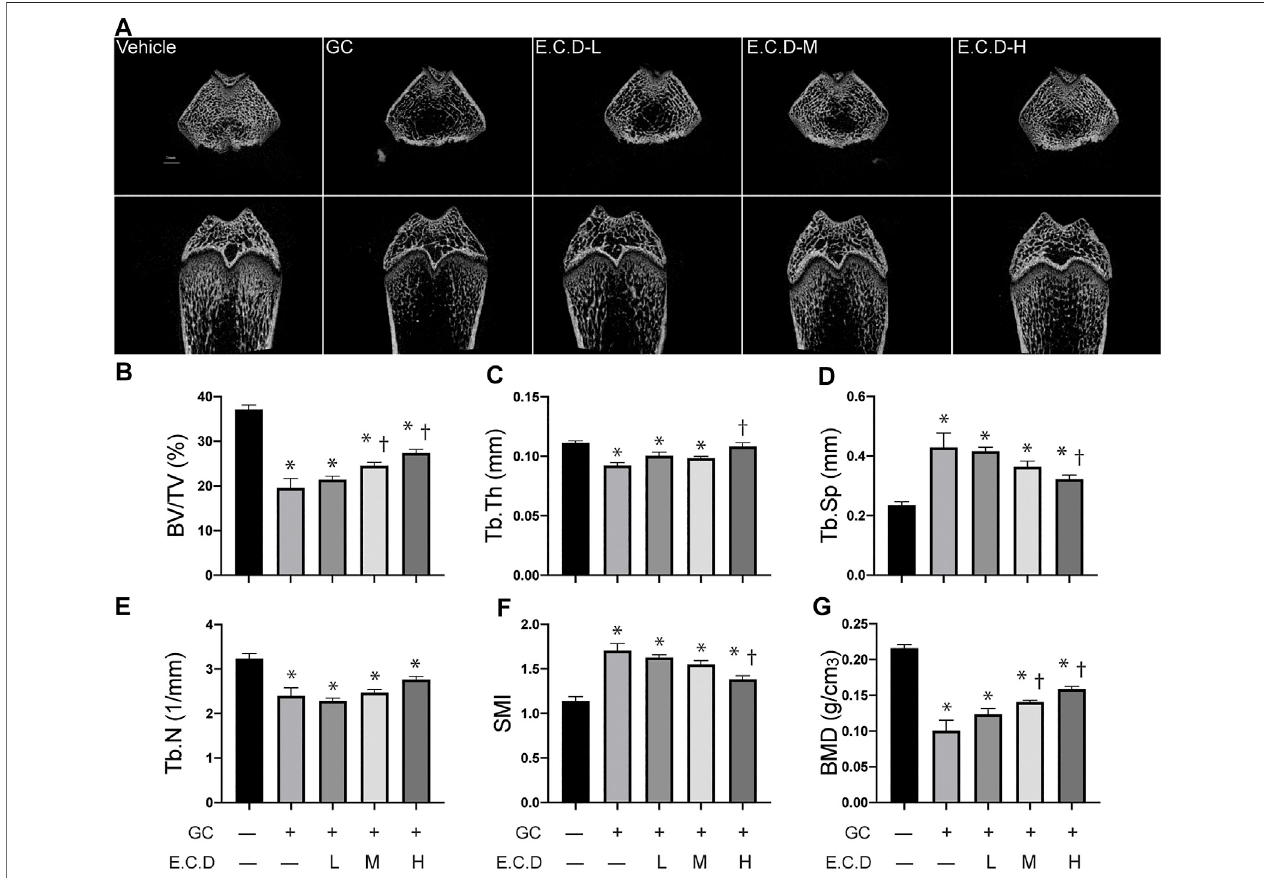
FIGURE 3 | E.C.D. extracts improved the integrity of bone structure and increased bone density by micro-CT scan. (A) The micro-CT scan was processed to assessthemicro-structureandthebiomechanicsofrats.Theupperpanelwasthetransversesectionofthefemur,andthelowerpanelwasthelongitudinalsectionofthe femur. The scale bar was labeled as 1 mm. (B – G) Bone volume/total volume (BV/TV), trabecular thickness (Tb.Th), trabecular separation (Tb.Sp), trabecular number (Tb.N), structural model index (SMI), and bone mineral density (BMD) were measured 8 weeks after GC administration of rats. The columns from left to right are Vehicle group, GC group, B.C.D. – L group, B.C.D. – M group and B.C.D. – H group, respectively, n = 8 in each group. Data were analyzed as mean ± SEM, * vs. Vehicle group (GC – E.C.D. – ), † vs. GC group (GC + E.C.D. – ), p <